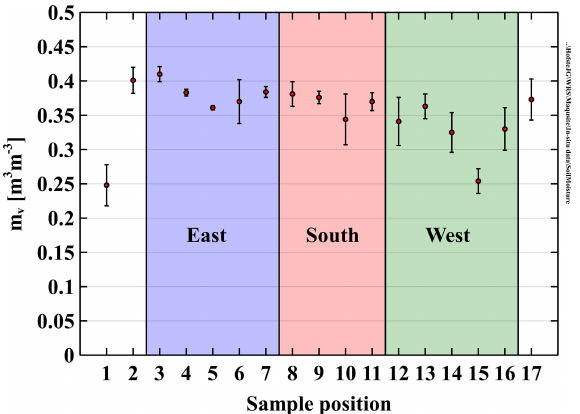
Figure A3. Top soil m v measured with handheld ThetaProbe at 17 sample positions along the no-step zone periphery (indicated Fig. 2). Vertical bars denote minimum and maximum values of the three measurements per sample position. Red dots represent median values.